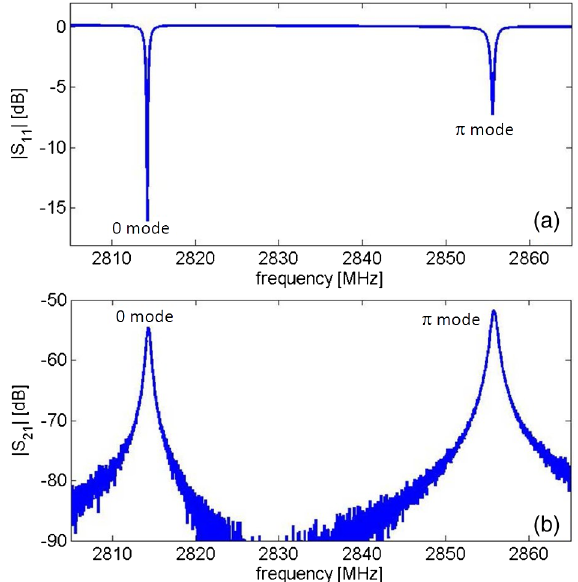
FIG. 18. (a) Measured reflection coefficient at the waveguide input port; (b) measured transmission coefficient between the waveguide and the